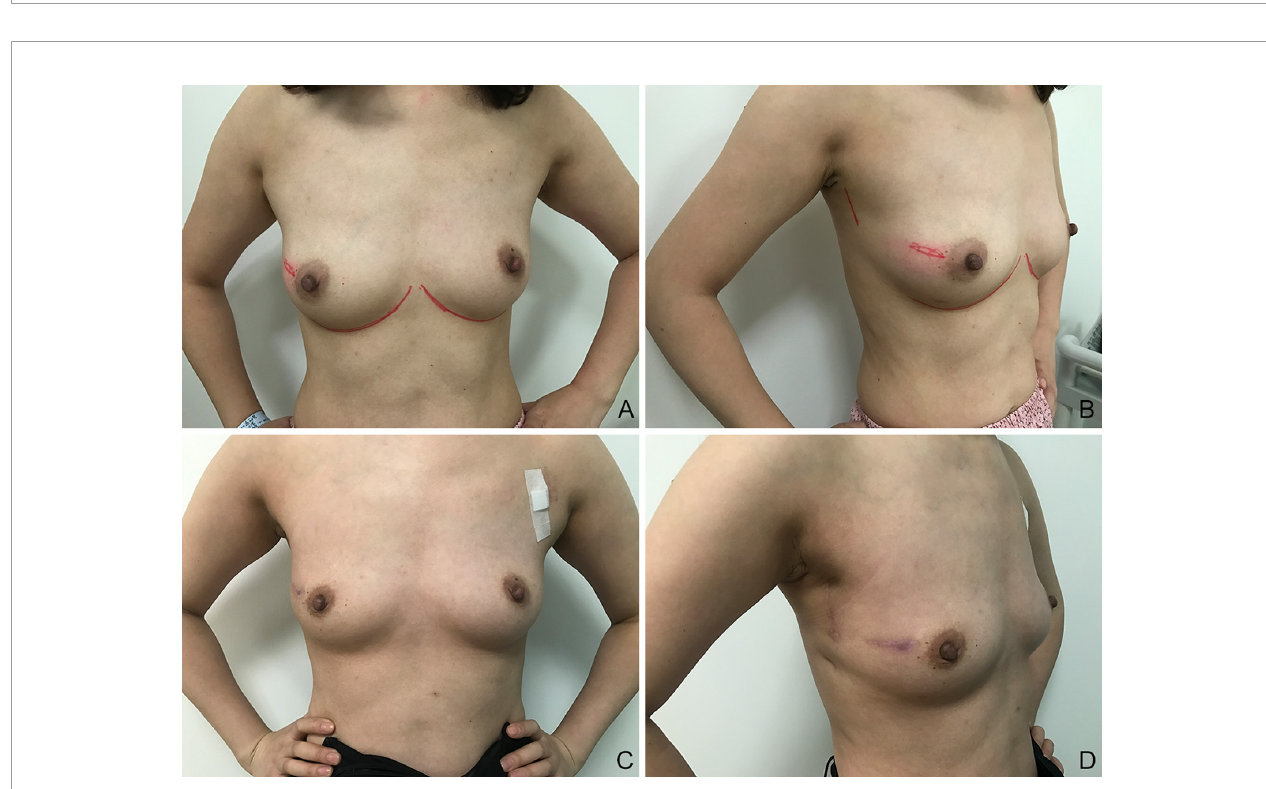
FIGURE 3 | Images of a 36-year-old patient, which were obtained 1 year after right breast-conserving surgery with partial latissimus dorsi fl ap (BCSPLD) for breast reconstruction. (A) Frontal view before surgery; (B) lateral view before surgery; (C) frontal view after surgery; (D) lateral view after surgery.